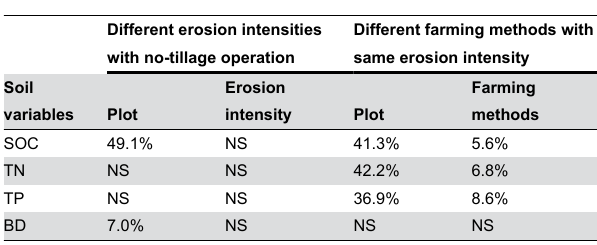
Table 2. Shared variation of each significant soil variable and historical erosion (plot), erosion intensity, and farming method data.